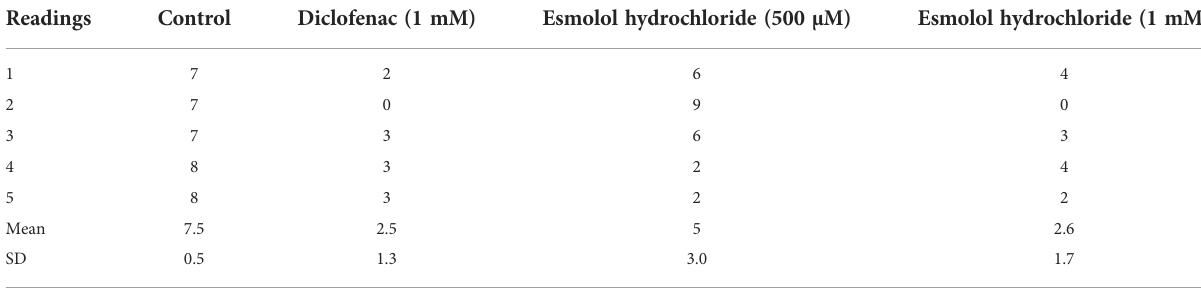
TABLE 2 Fluorescence measurements in the presence of esmolol hydrochloride. Readings